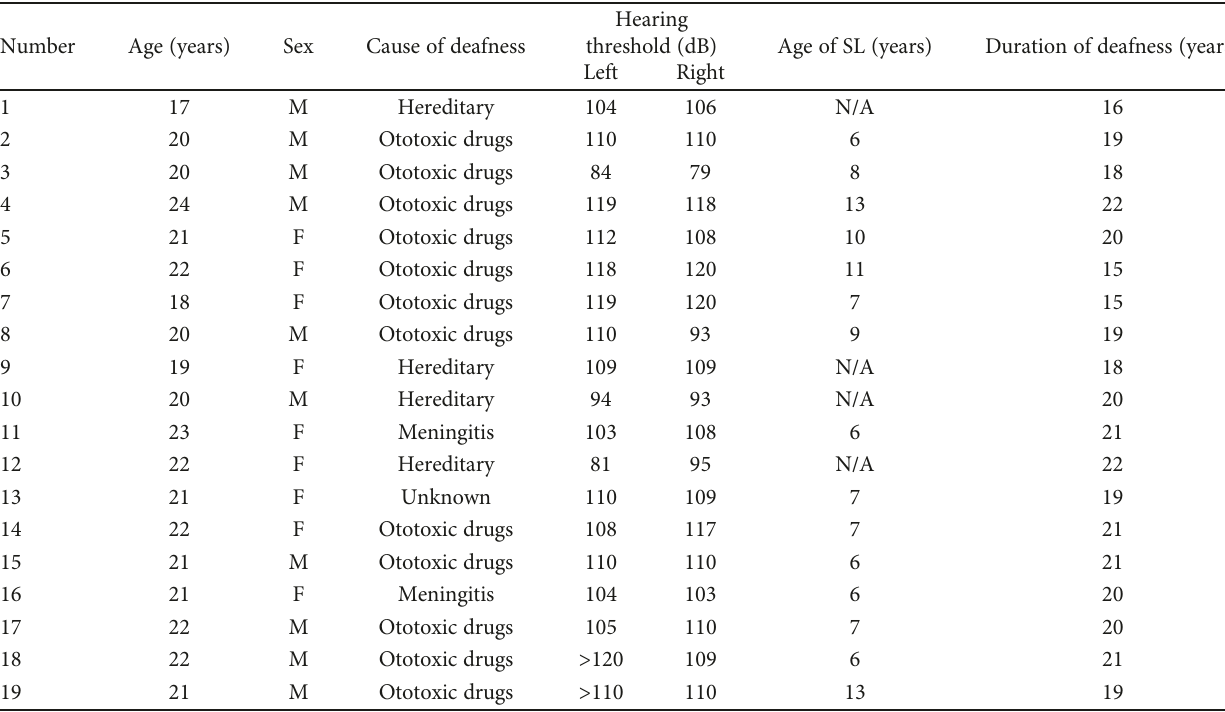
Table 1: Demographic data of the